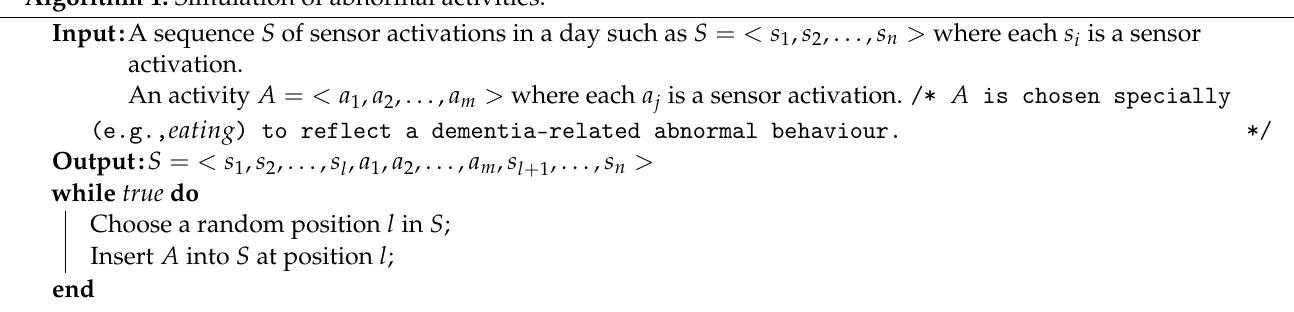
Algorithm 1: Simulation of abnormal activities.